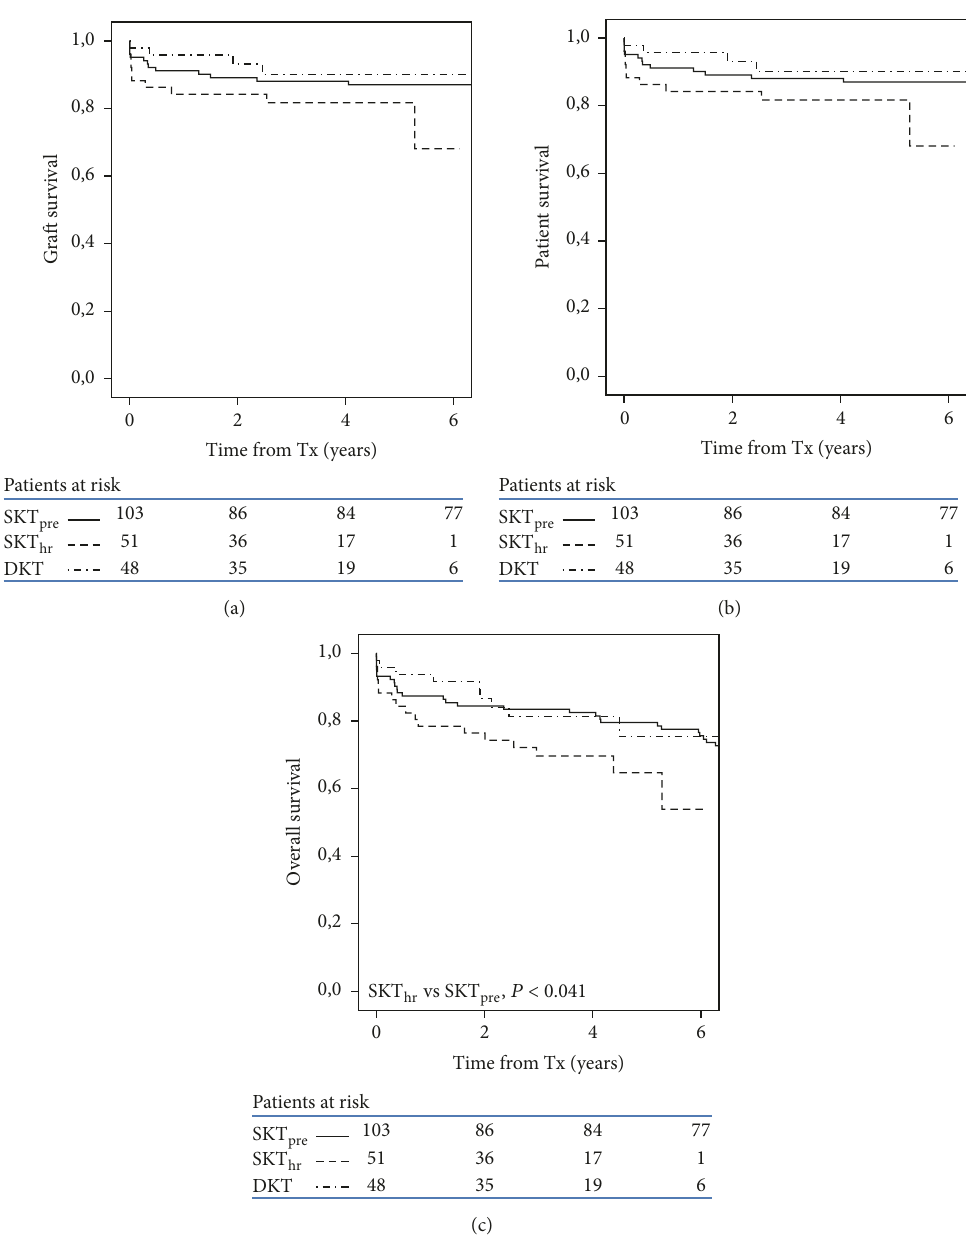
Figure 4: Kaplan-Meier plots of graft (a), patient (b), and overall survival (c) in recipients of high-risk ECD by transplant category. Overall survival is statistically lower in SKT as compared to SKT hr pre